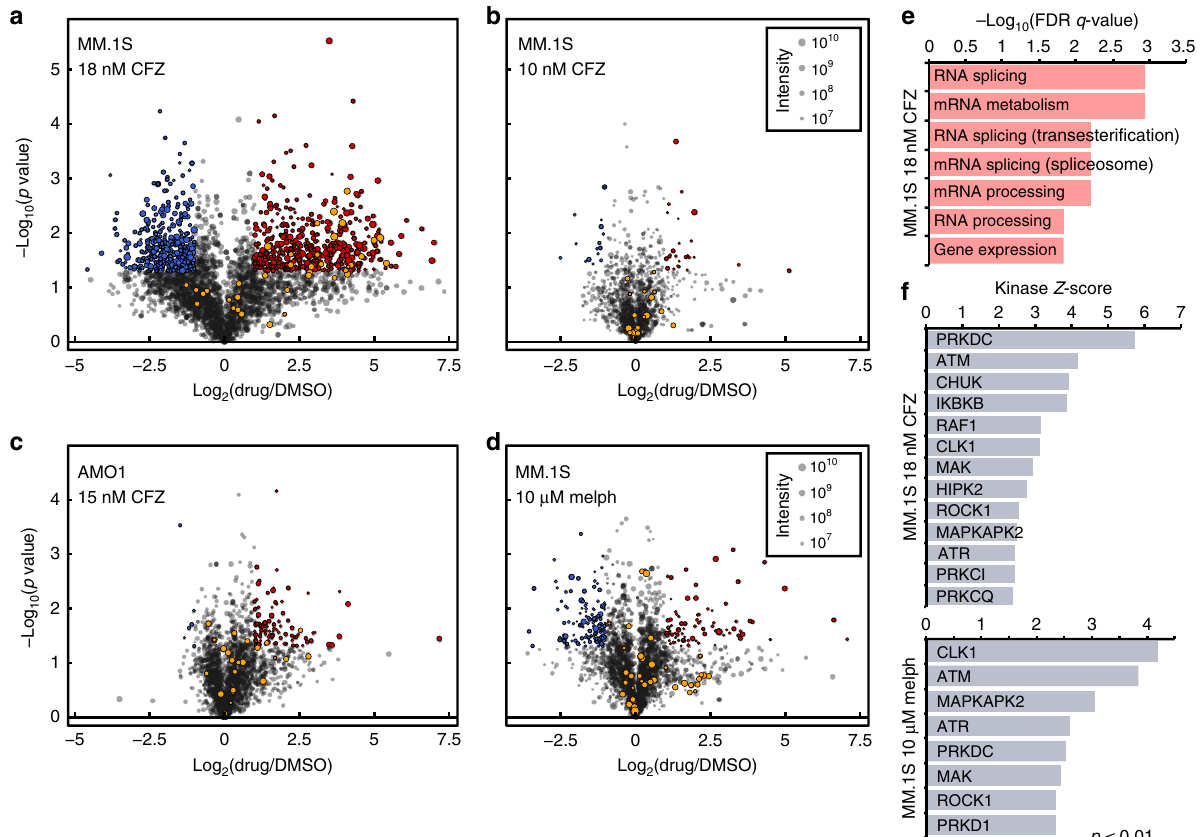
Fig. 2 Cfz induces phosphorylation of splicing factors in a dose-responsive manner. a – d Volcano plots of log 2 -transformed ratios of phosphosite abundances between a MM.1S treated with 18 nM Cfz, b 10 nM Cfz, or d 10 μ M melphalan compared to DMSO and c AMO-1 with 15 nM Cfz compared to DMSO. Signi fi cant upregulated sites are in red, while downregulated are in blue (>2-fold change, p < 0.05). SRSF-related sites are in orange. Circle size corresponds to summed SILAC intensities. e Top-ranked GO terms for genes with signi fi cantly upregulated phosphosites in MM.1S cells treated with 18 nM Cfz. f Top ranked KSEA-activated kinases (with at least 5 substrates) for MM.1S treated with 18 nM Cfz (top panel) and 10 μ M melphalan (bottom